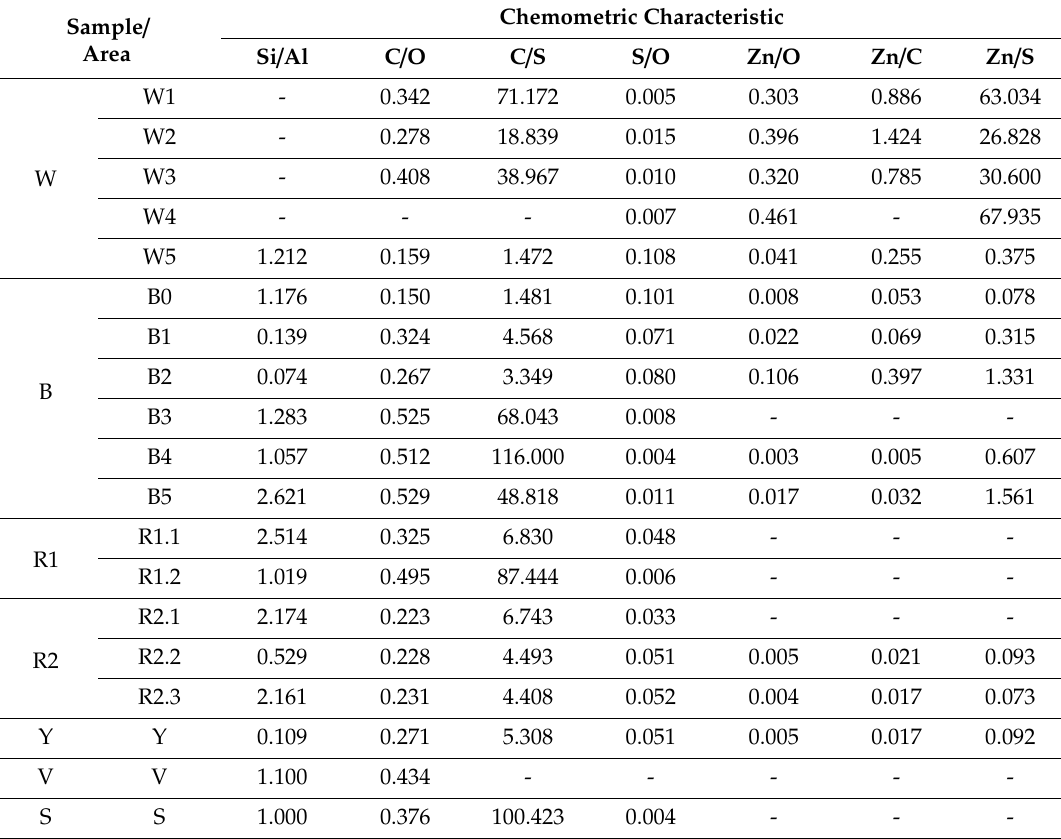
Table 3. Evaluation of chemometric characteristics, with archaeometric